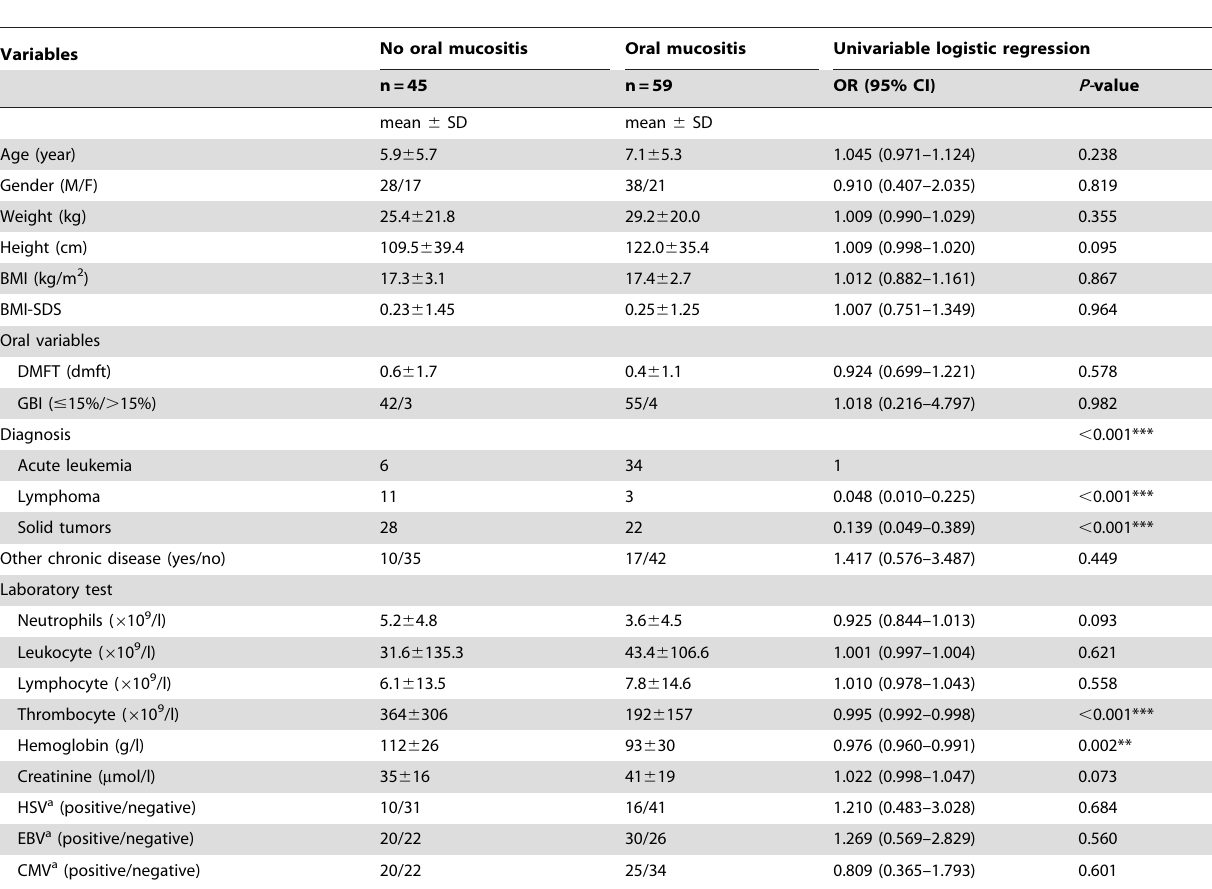
Table 2. Univariable logistic regression with patient-related factors at the time of malignancy diagnosis as independent variables and oral mucositis as the outcome in all patients